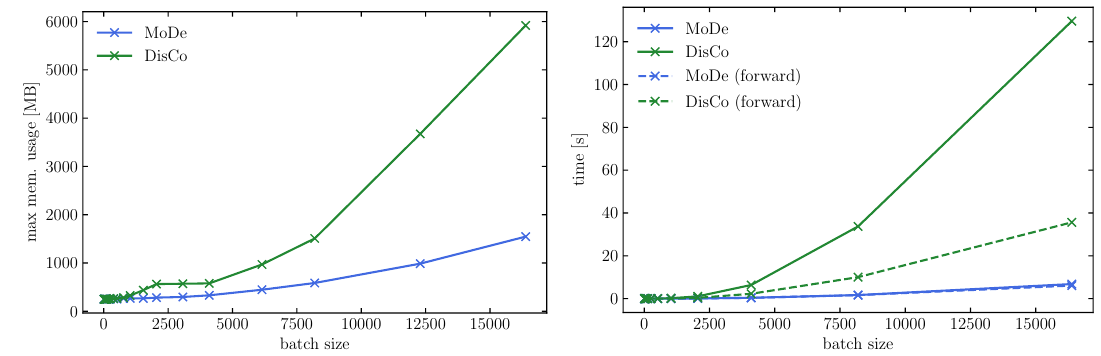
Figure 9 . Maximum memory usage and CPU time for different batch sizes of triples ( s i , m i , y i ) .